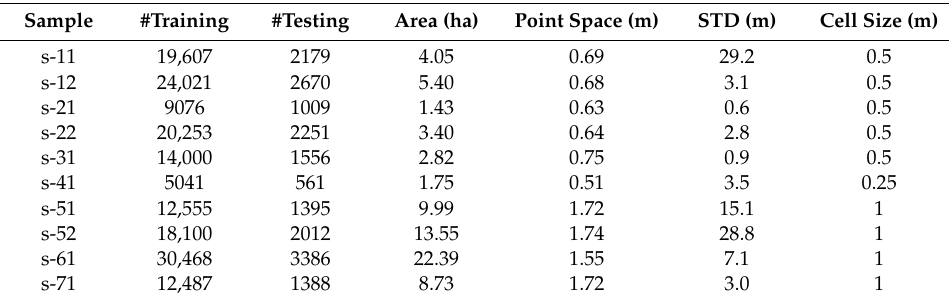
Table 4. Data description for each